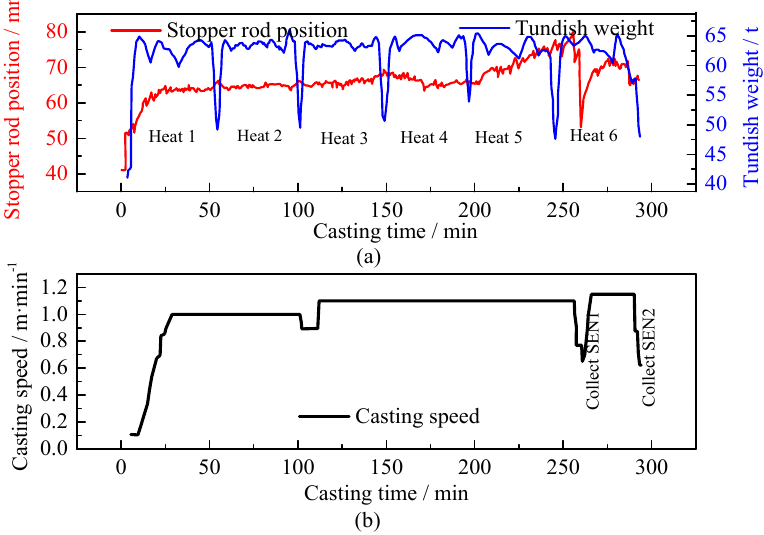
where, V c is the actual volume of the flow region in the SEN with clogs, m 3 ; and V n is the Figure 1. ( a ) The stopper rod position and tundish weight curve, ( b ) the casting speed curve. initial volume of the flow region in the SEN under the slag-line without clogs. The typical morphologies of offline SENs are shown in Figure 2a–d. Here, three pa- rameters were introduced to describe the clog morphology and establish a SEN clog ge- ometry model, as shown in Figure 2e. The parameters x and y represent the port width and height of the clogged nozzle, respectively, and the block rate of the SEN was defined as Equation (1) to quantify the volume of nozzle clogs.